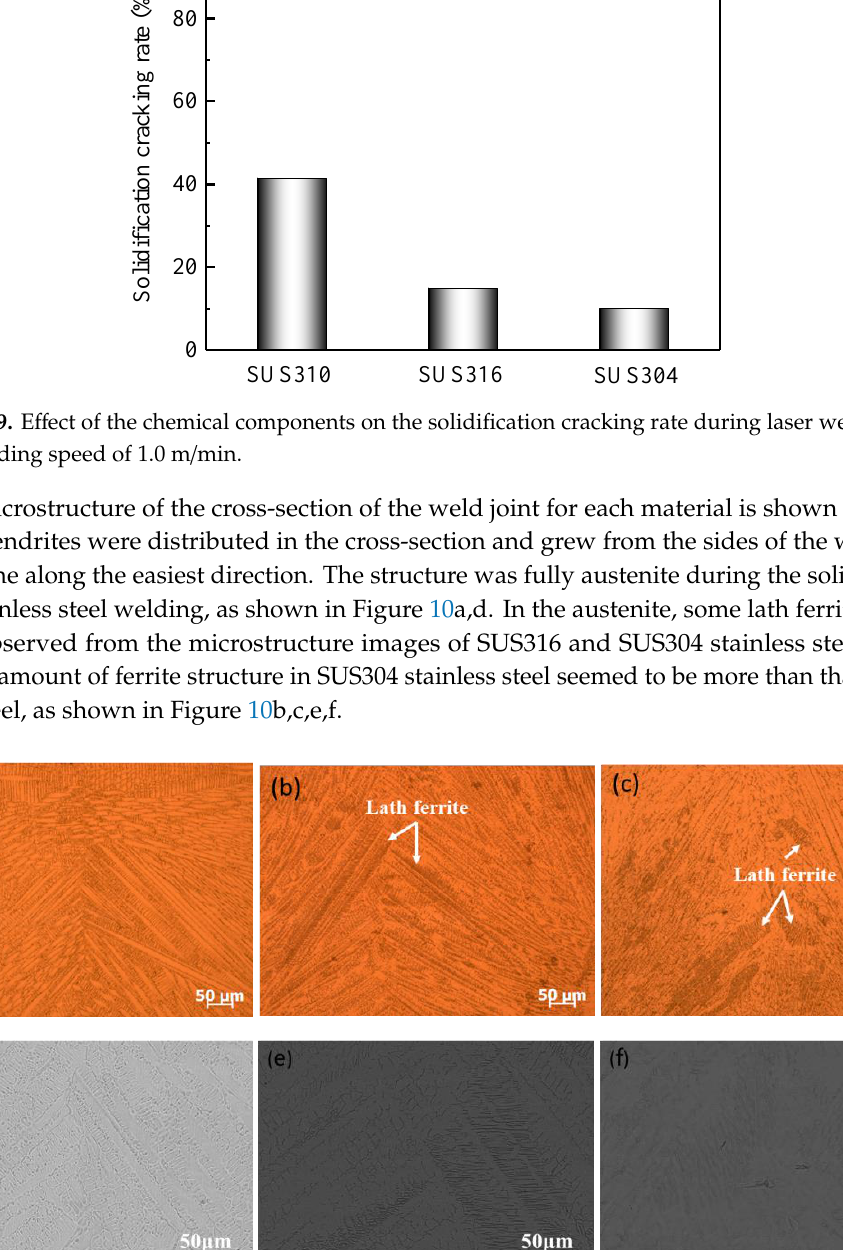
Figure 8. Effect of ( 1/2 )W S on the solidification cracking length of the SUS316 and SUS304 stainless steels during laser welding at a welding speed of 1.0 m/min.